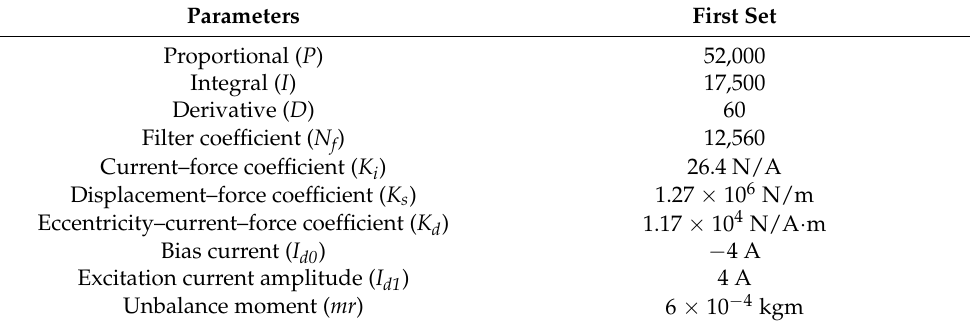
Table 3. Main parameters for